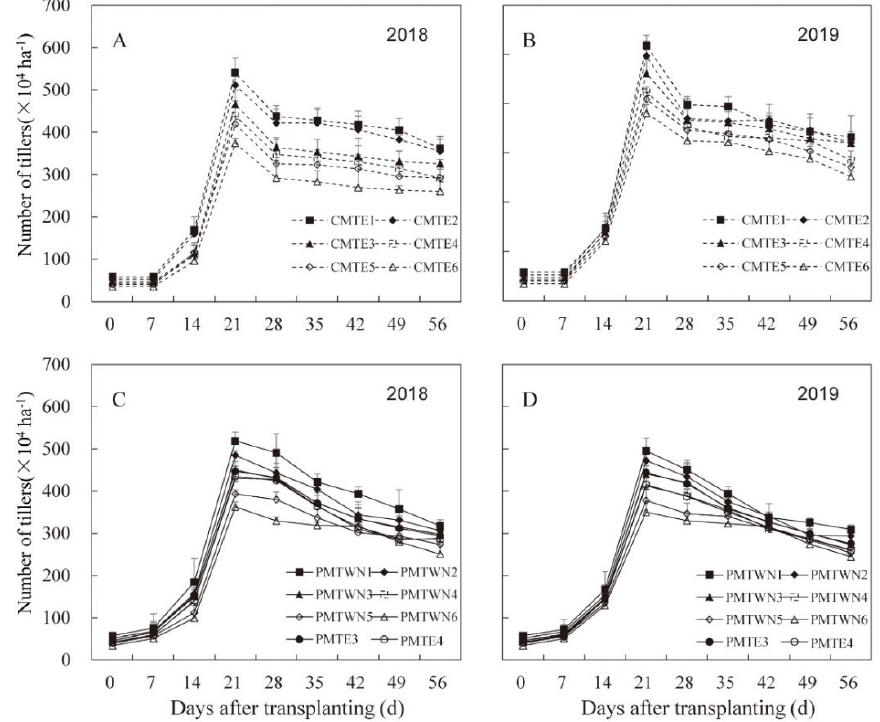
Figure 2. Rice tiller dynamic under different mechanical transplanting methods and planting geom ‐